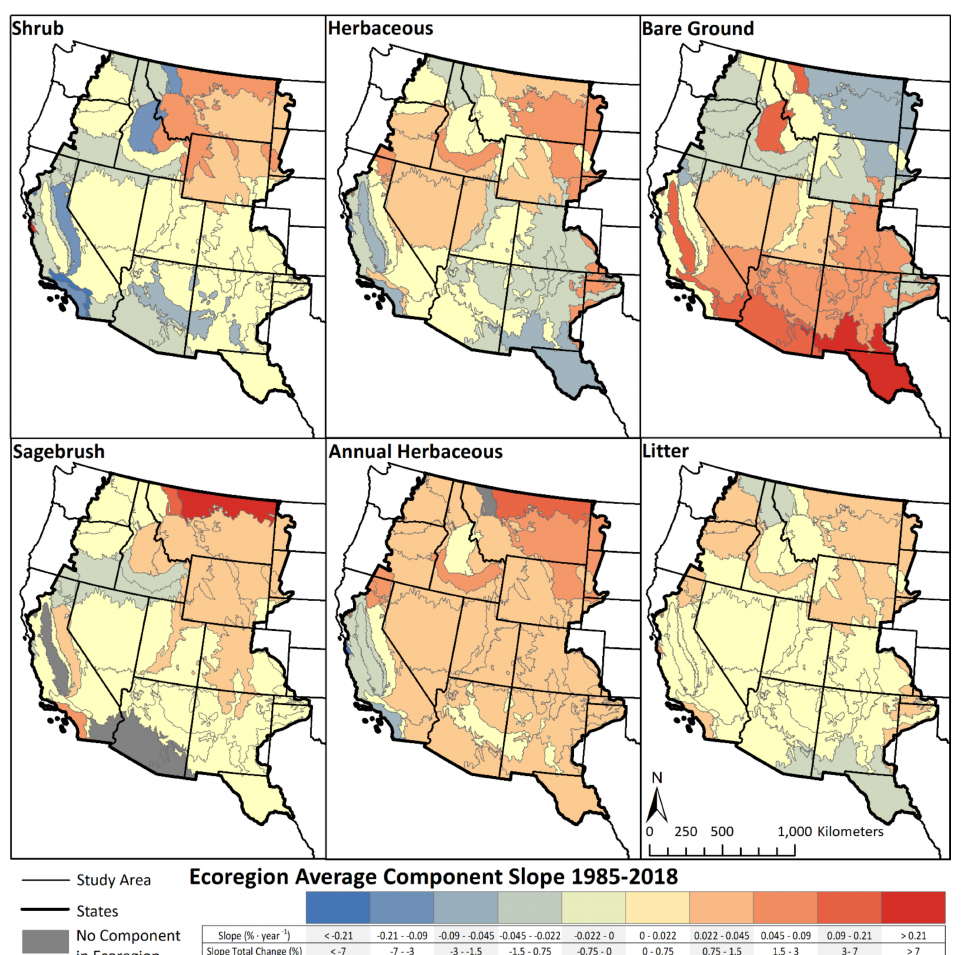
Figure 5. Component cover trends from 1985 to 2018 in rangeland pixels averaged by Environmental Protection Agency Level III